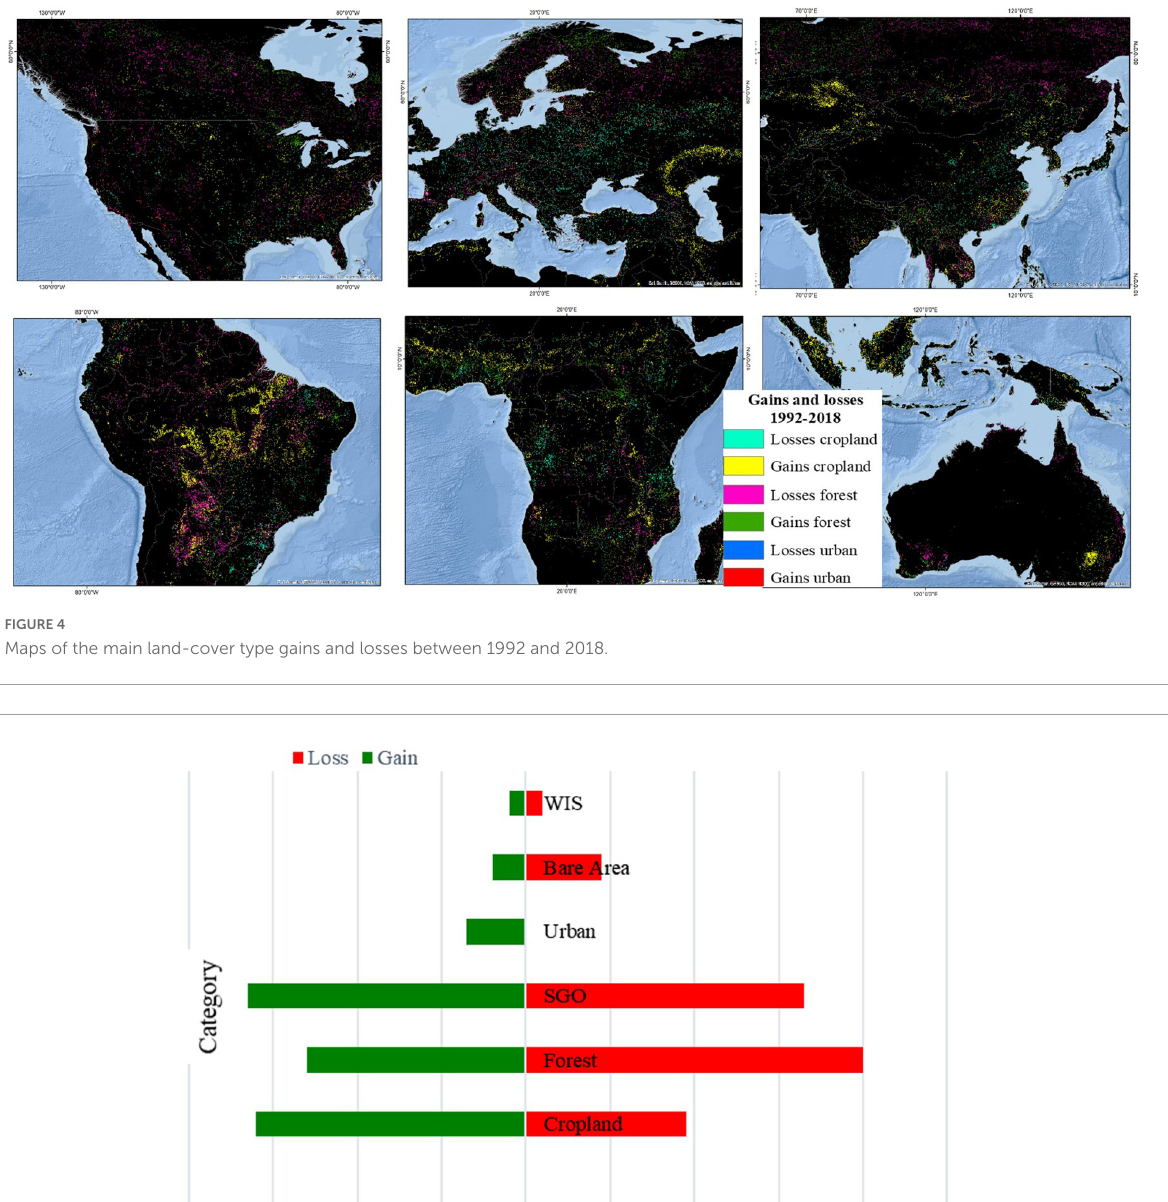
(23,280 km 2 ), respectively, while Forest decreased by 3.2% (579,108 km 2 ). Also, in Australia and Oceania, Cropland increased by 0.40% (34,120 km 2 ), while Bare Area and Forest declined by 0.42% (34,780 km 2 ) and 0.24% (20,484 km 2 ),